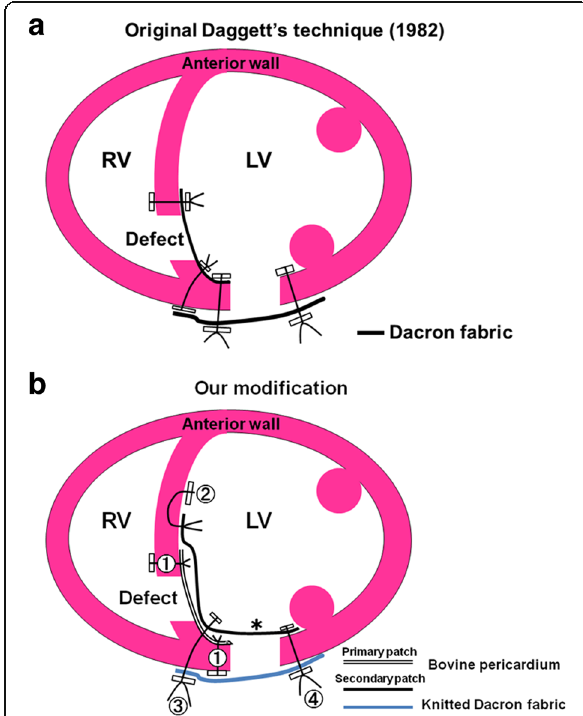
Fig. 1 Schematic diagrams of the repair techniques. a The Daggett ’ s technique. The left ventricular defects are closed separately in a single layer. b The modification described in the text. Sutures are numbered and placed in numerical order. A cross section shows the secondary endoventricular patch (asterisk) closes both the septal and ventriculotomy defects separately with the hinge stitches between ( ③ )